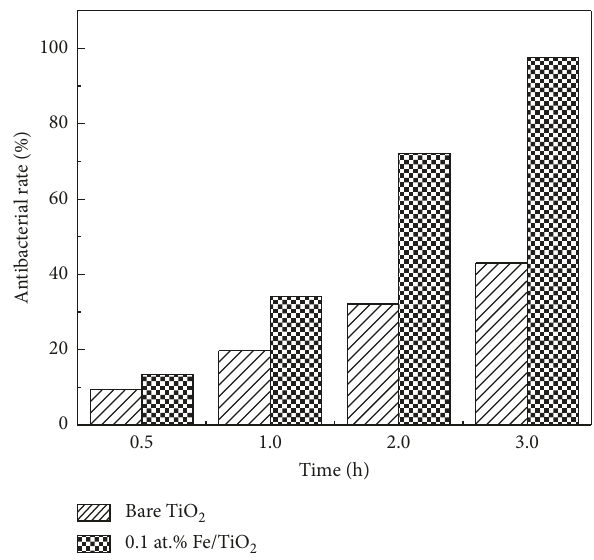
Figure 8: Antibacterial rate of 0.1 at% of Fe-doped TiO bare TiO 2 film in dye waste